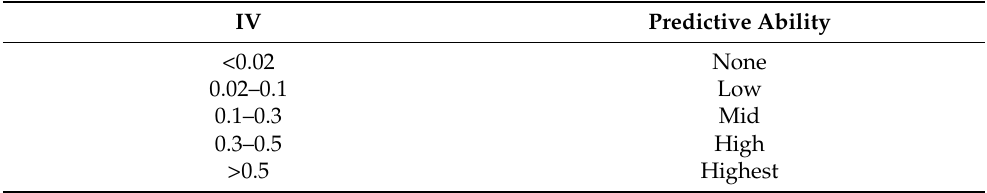
Table 1. Thresholds of